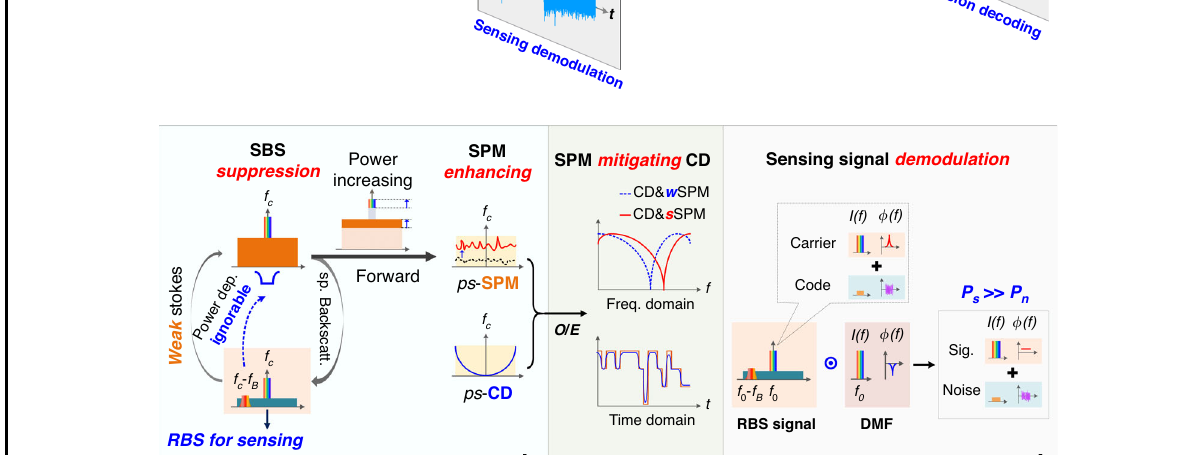
is generated and mapped into PAM4 with 2 samples per symbol. The upsampled signals are shaped using a square root raised cosine (SRRC) with a roll-off factor of 0.1. Next, a pre-distortion operation is utilized to over- come the frequency roll-off of the digital-to-analogue converter (DAC). Before being injected into the 24.5 km SMF, the transmission light is enhanced by an EDFA (EDFA2) with 18 dBm output power, and the launching power is adjusted by a variable optical attenuator (VOA).